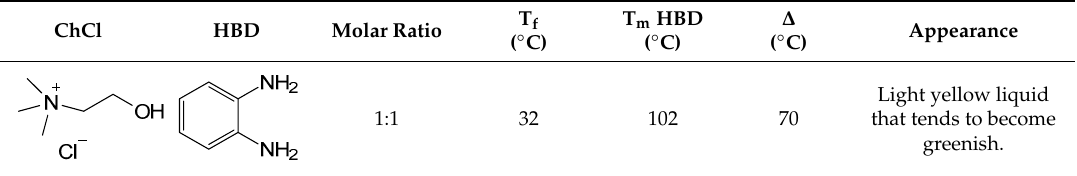
Table 2. Structure, composition, and eutectic temperature (T f ) of the deep eutectic solvents (DES) with the corresponding melting point (T m *) of the pure hydrogen bond donor (HBD). The temperature is given in °C. HBD